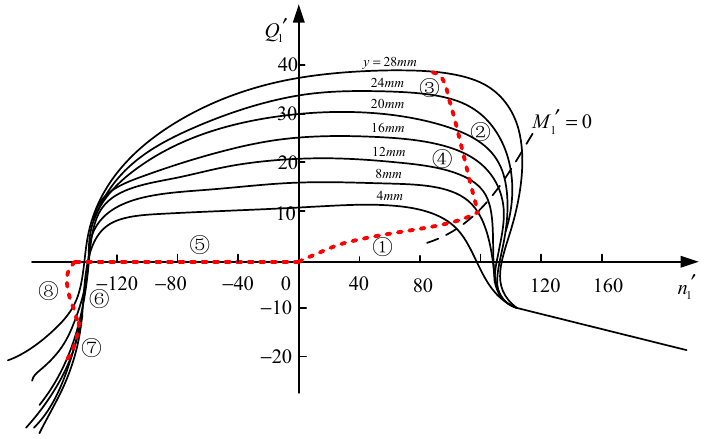
Figure 4. Full-characteristic curve of pump-turbine and main transition process path.